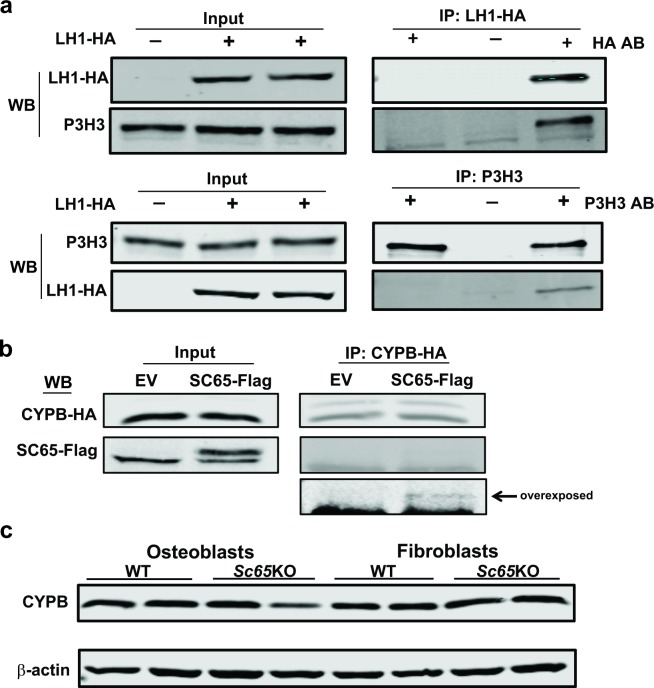
Characterization of a new SC65/LH1/P3H3 complex in the ER.a) Lysates of 714 mouse embryonic fibroblasts that were transiently transfected with an HA-tagged LH1 expression construct were immuno-precipitated with a HA antibody (upper panel) or a P3H3 antibody (lower panel). 10% of total inputs and immuno-precipitates were separated on a 8% SDS-PAGE gel, blotted and probed with antibodies against HA and P3H3. Negative controls included non-transfected 714 cells incubated with the HA antibody (for non-specific binding of HA antibody, left lanes) and LH1-HA transfected cells incubated with no antibody (for non-specific proteins binding to beads, middle lanes). In both experiments, LH1-HA and P3H3 were found to interact (right lanes). b) Lysates of 714 mouse embryonic fibroblasts stably expressing SC65-Flag or EV control and transiently transfected with a HA-tagged CYPB were used for IP utilizing an HA antibody. 10% of total input and immuno-precipitates were separated on a 12% SDS-PAGE gel, blotted and probed with antibodies against Flag and HA. The blot detecting SC65-Flag following IP with the HA antibody is shown over-exposed. c) Western blot of primary calvarial osteoblast and skin fibroblast lysates from WT and Sc65KO 3 day-old mice (N = 2) showing similar content of CYPB protein in Sc65KO and WT samples. All experiments were performed at least 3 times.